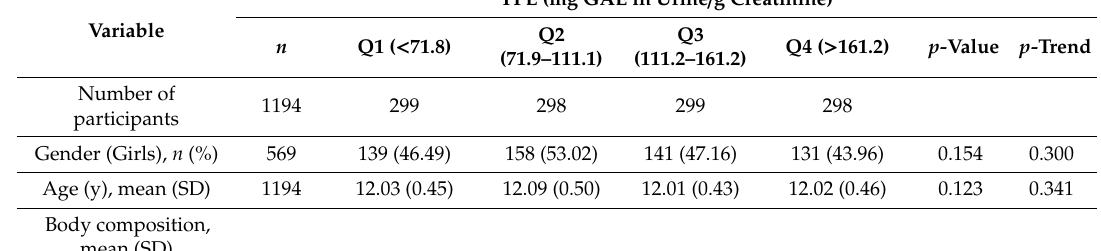
Table 2. Baseline characteristics of the study population, according to TPE quartiles (mg GAE in urine / g creatinine).